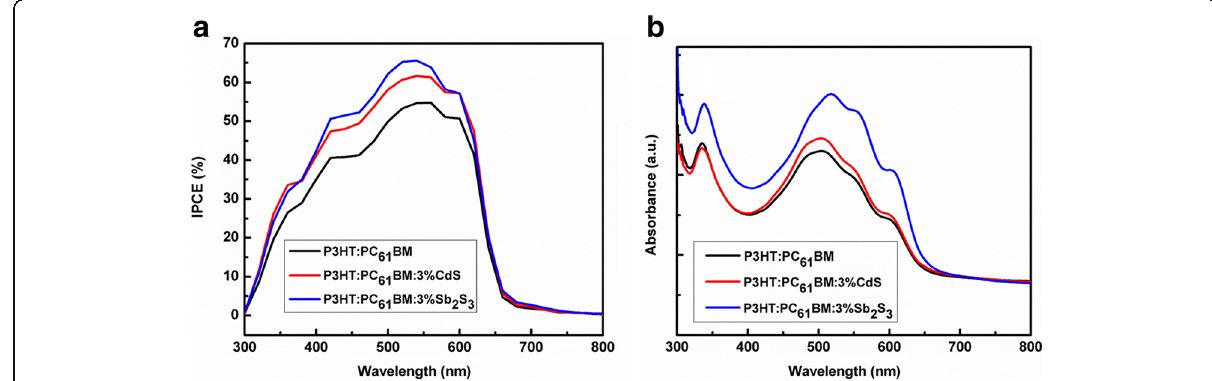
Fig. 4 a IPCE curves of the HSCs based on P3HT:PC 61 BM, P3HT:PC 61 BM:3 wt.% CdS, and P3HT:PC 61 BM:3 wt.% Sb 2 S 3 . b UV – Vis absorbance spectra of the films of P3HT:PC 61 BM, P3HT:PC 61 BM:3 wt.% CdS, and P3HT:PC 61 BM:3 wt.% Sb 2 S